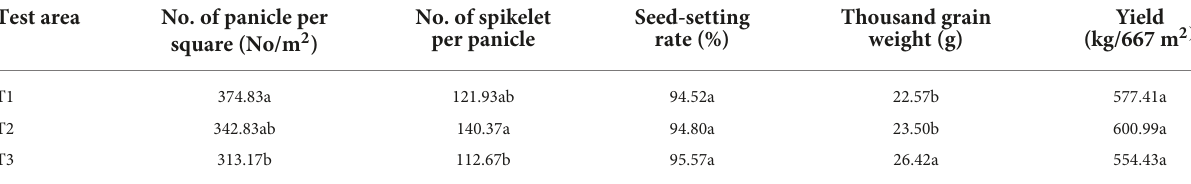
TABLE 3 Effect of different cultivation methods on grain yield and its components of rice. Test area